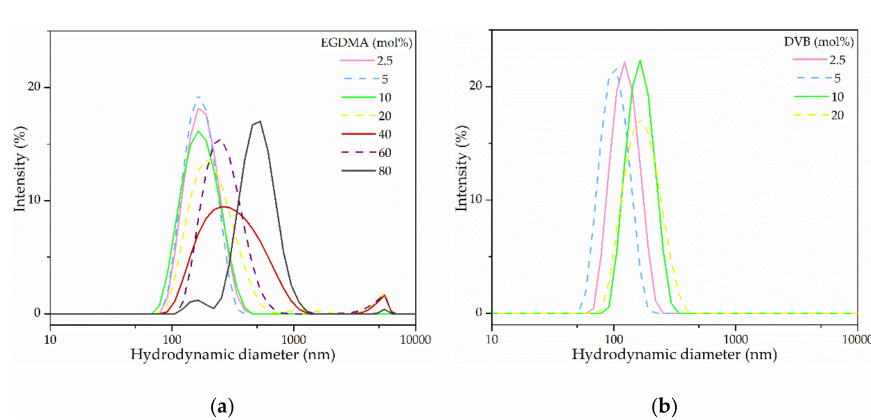
Figure 4. Hydrodynamic diameter distribution curves in terms of intensity (%) obtained via DLS analysis of ( a ) PMMA- co -EGDMA- co -AUPDS and ( b ) PS- co -DVB- co -AUPDS particles formulated using with different amounts of cross-linker (in mol% in regards to the dispersed